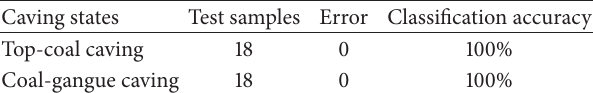
Table 3: Classification results of